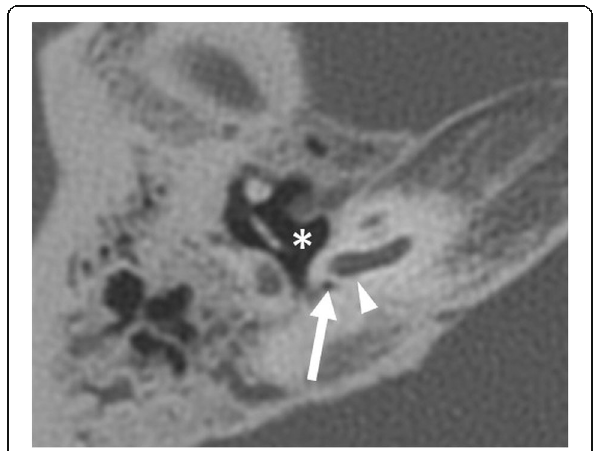
Fig. 13 A 65-year-old male patient, with external auditory canal hypoplasia and bilateral SNLH from birth. HRCT axial image shows a hypoplastic round window (arrow) and a small tympanic cavity (asterisk). This condition complicates anatomical orientation and surgical access to the basal turn (arrowhead)